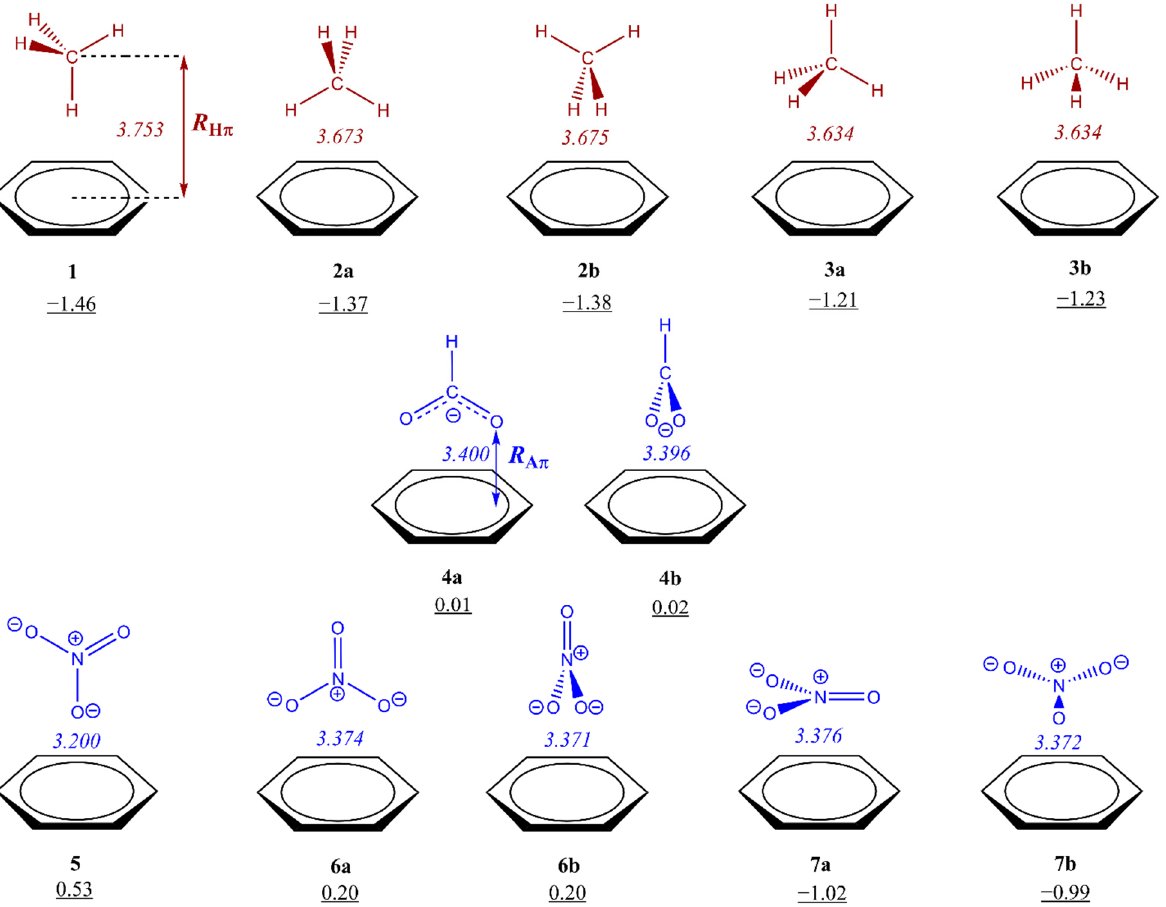
Figure 1. CH/ π ( 1 – 3 ) and anion– π ( 4 – 7 ) complexes under study. Binding energies (in kcal/mol) are Figure 1. CH/ π ( 1 – 3 ) and Anion– π ( 4 – 7 ) complexes under study. Binding energies (in kcal/mol) are underlined, and equilibrium distances (in Å ) are shown in italics. underlined, and equilibrium distances (in Å) are shown in